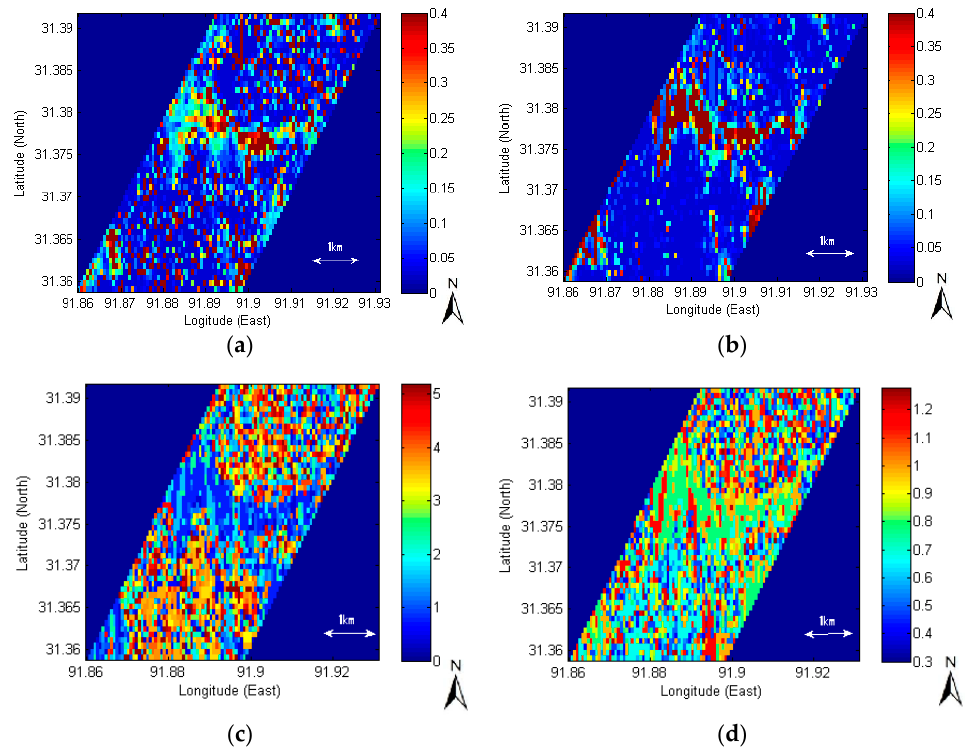
Figure 2. Roughness experiments: ( a ) soil moisture retrieval by s scheme #2 (m 3 /m 3 ); ( b ) soil moisture (s scheme #4), m 3 /m 3 ; ( c ) correlation length, cm; and ( d ) RMS height (s scheme #4), cm on DoY 221.